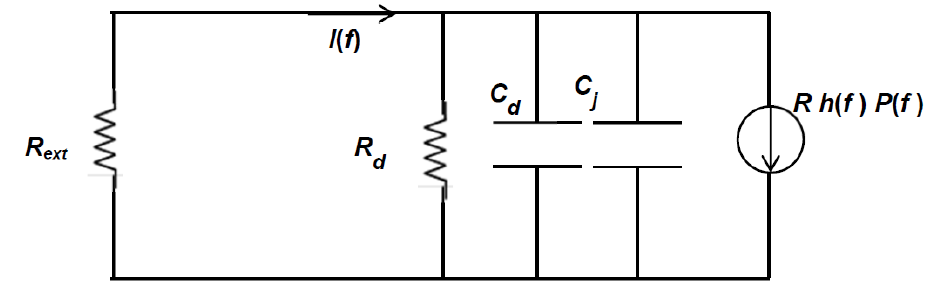
Figure 3. Circuit model of a solar cell as a data receiver [15].